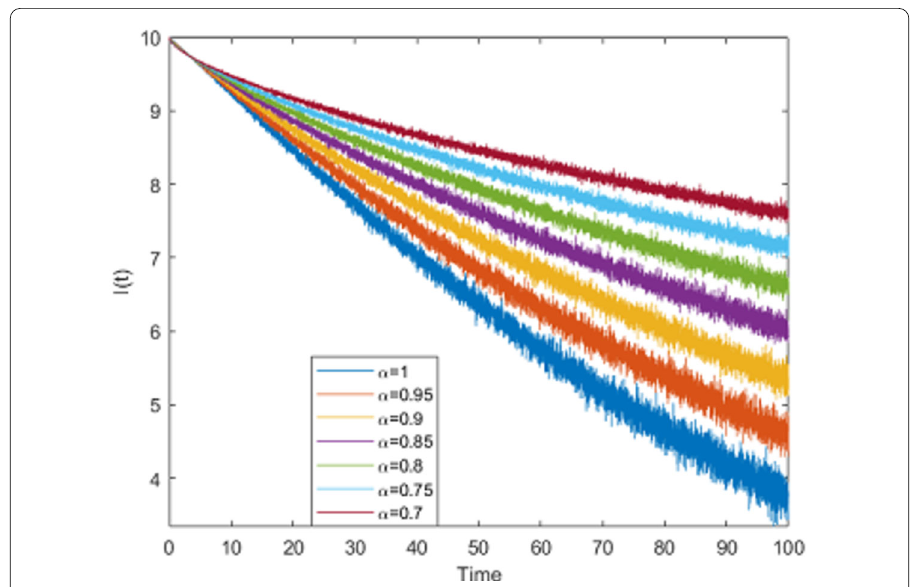
Figure 15 The class of researchers affected by criticisms for σ 2 = 0.00031